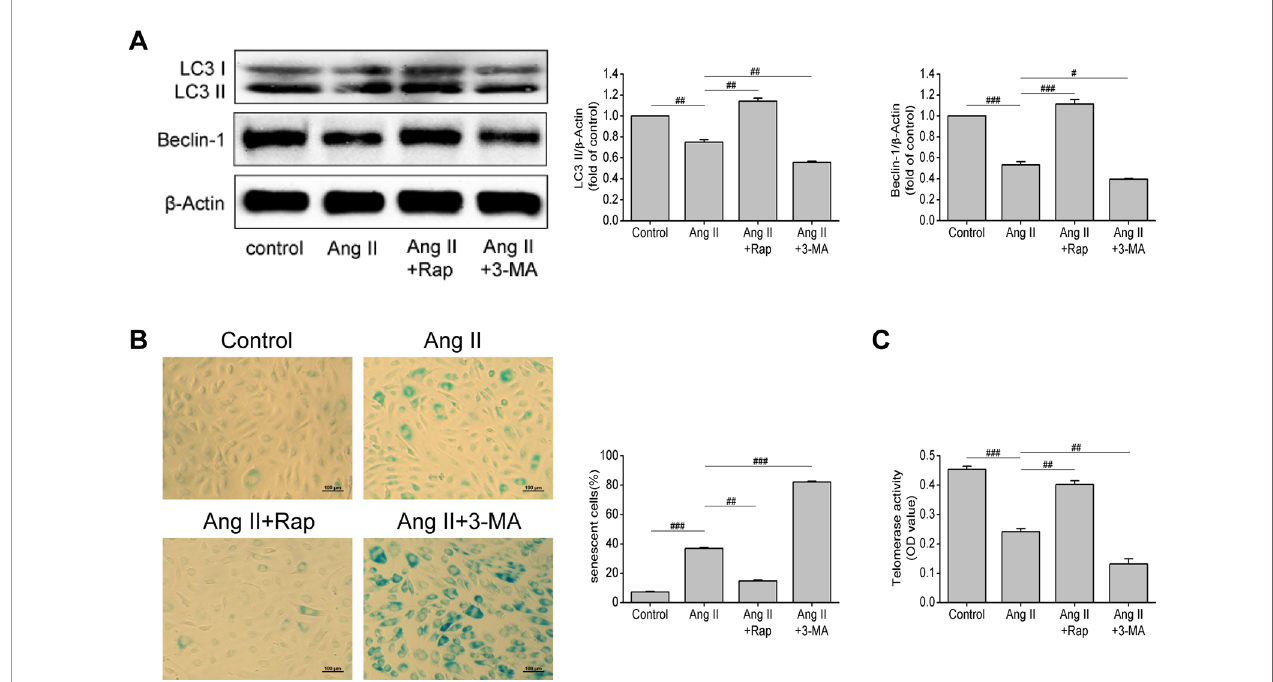
FIGURE 3 | Enhancing autophagy attenuated Ang II-induced EPCs senescence. (A) Western blot analysis of LC3-II and beclin-1 in EPCs in indicated groups. The data was presented in fold of control. (B) Representative images and quantitative analysis of SA- b -gal activity assay (100× magni fi cation). (C) Telomerase activity was determined by telomeric repeat ampli fi cation protocol assay and indicated by the difference value (OD = A450-A690). All data were pooled as mean ± S.D. (error bars) from three independent biological repeats experiments, each of which included 3 technical repeats. # P < 0.05; ## P < 0.01; ### P <